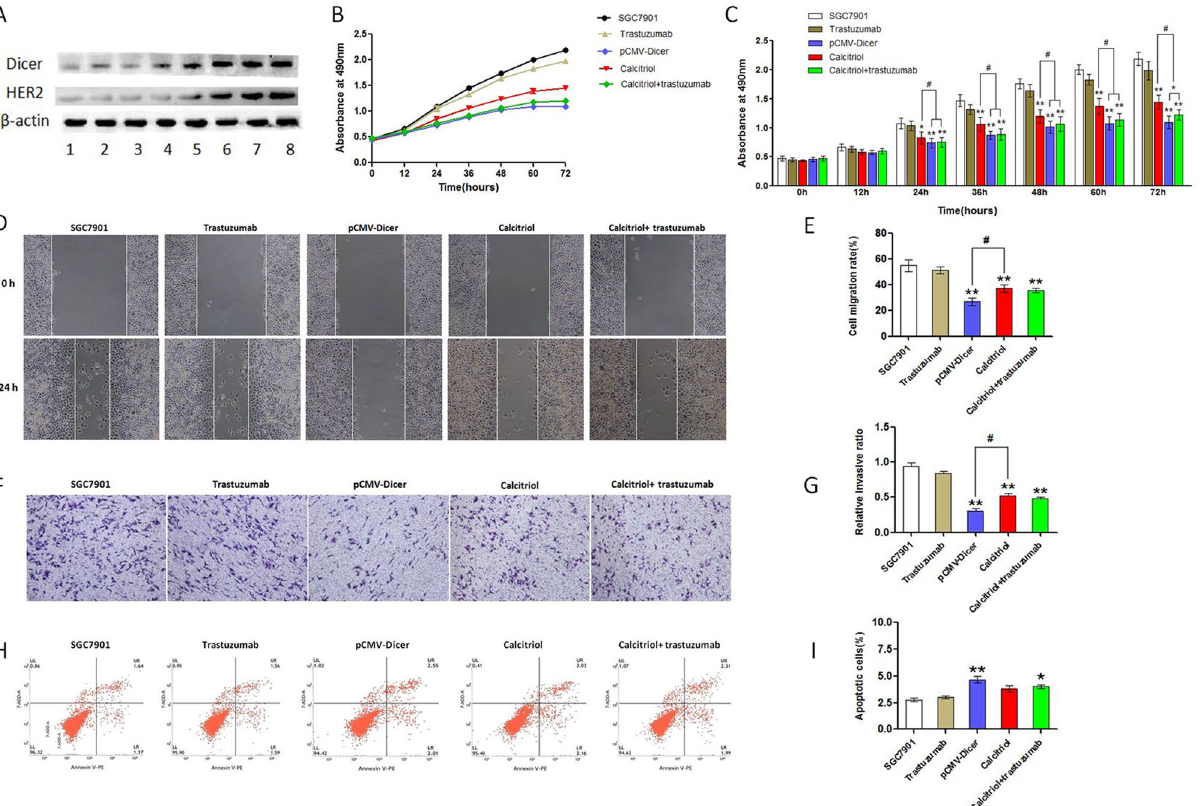
Figure 4. Calcitriol could induce HER2 expression and synergy with Trastuzumab for GC inhibition. ( A ) Western Blot analysis of Dicer and HER2 expression upon Calcitriol induction in SGC7901 cells, Line 1–7 with Calcitriol concentration of 1, 2, 4, 6, 8, 10 and 15 mmol/L, Line 8: pCMV-Dicer. The grouping of gels/ blots cropped from diferent parts of the same gel, the full blots are shown in Fig. S4; ( B , C ) The SGC7901